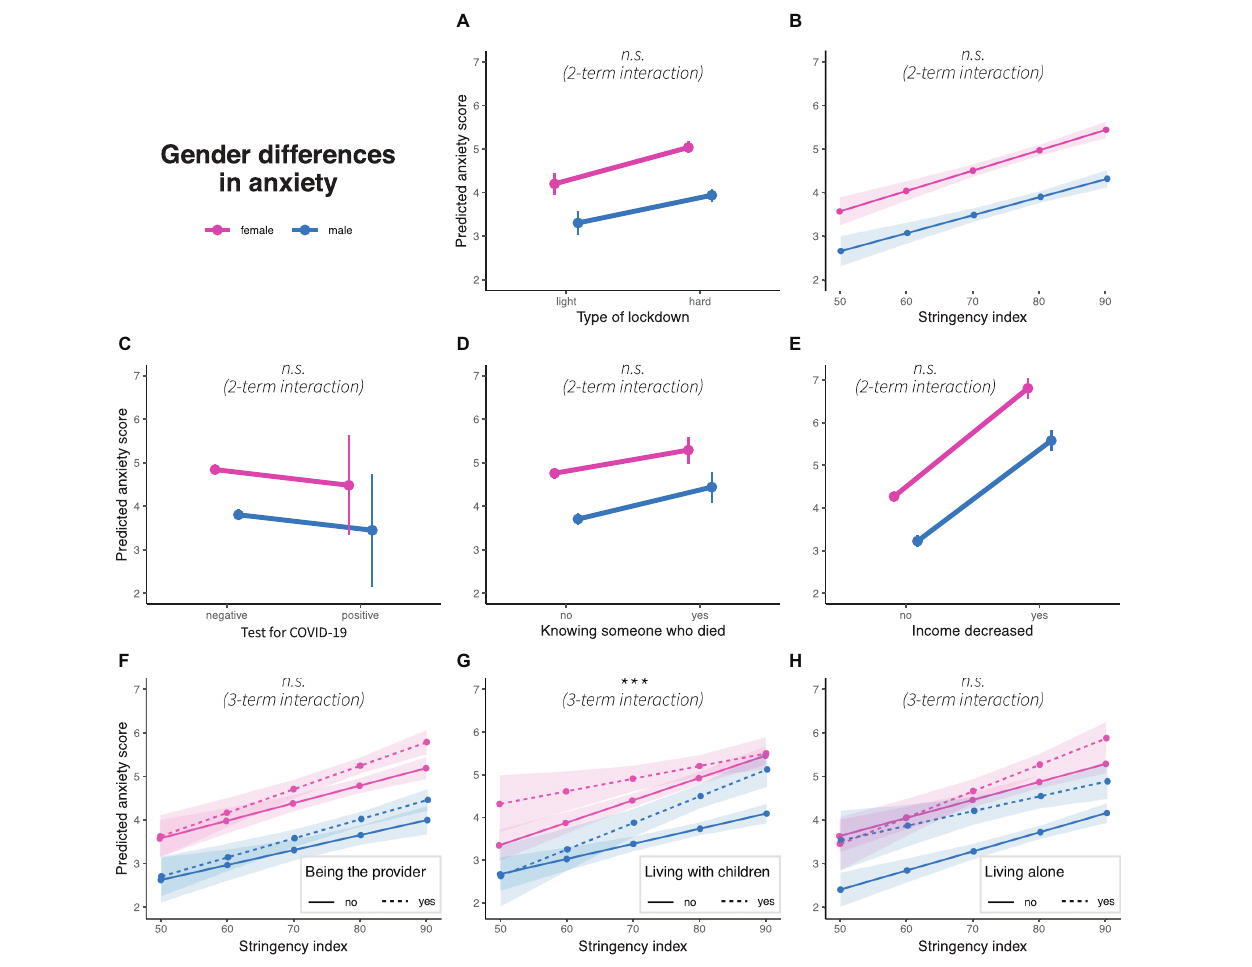
FIGURE 3 | Gender differences in predicted anxiety scores concerning (A) type of lockdown, (B) stringency index, (C) test for COVID-19, (D) knowing someone who died due to pandemic, (E) income decrease, and interaction of stringency index with (F) being the main household provider, (G) living with children and (H) living alone. Colors represent gender, dots represent marginal means, error bars or ribbons represent 95% confidence intervals. Linetypes represent at the bottom additional interaction terms. Significance of interaction effects are shown in italics; n.s.: non-significance. *** p < 0.01.